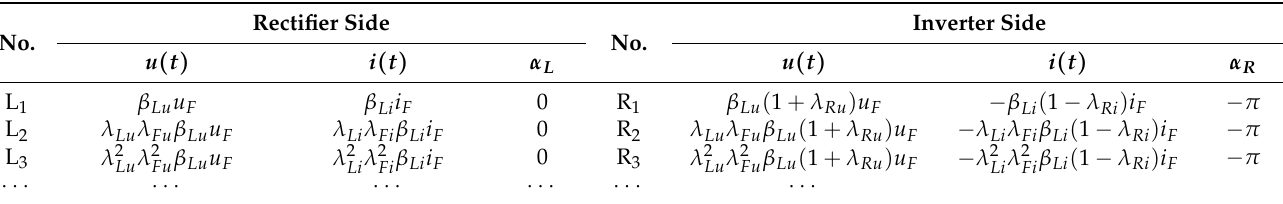
Table 2. Two terminals’ TW mutations with external